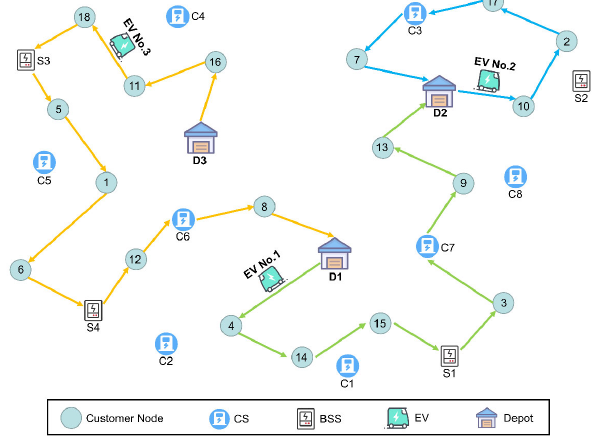
Fig.1. Schematic of the